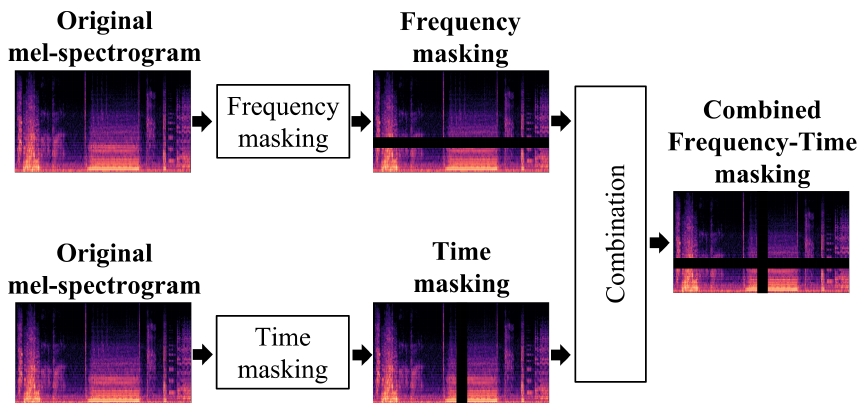
Figure 3. Example of time and frequency